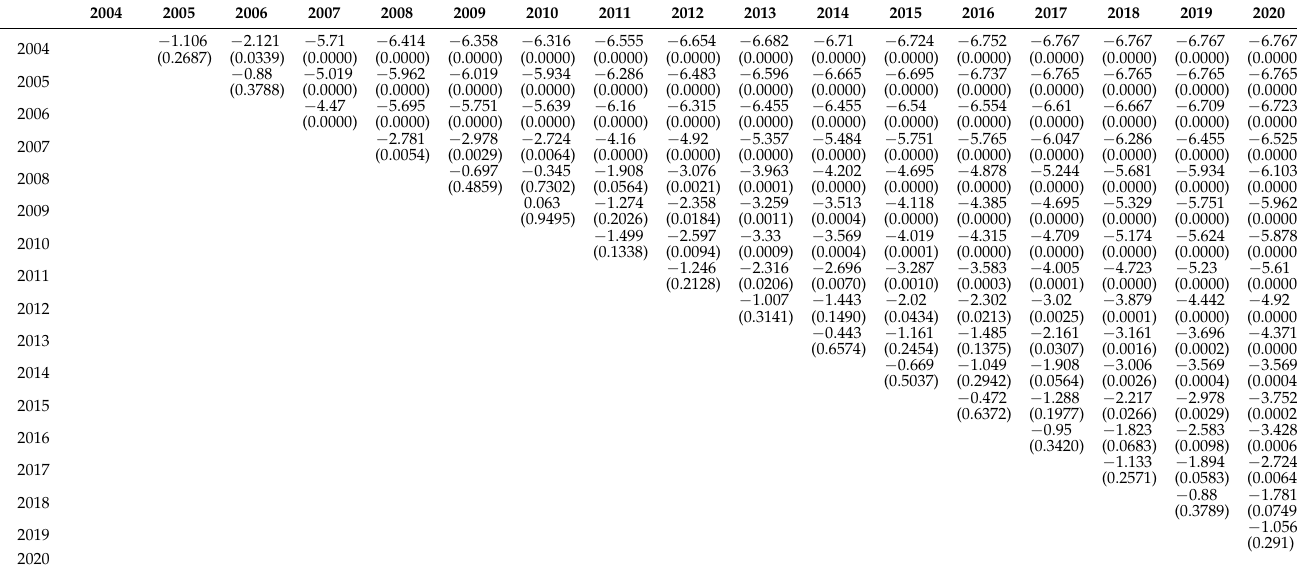
Table A1. The Increasing Rent Pattern: Mann–Whitney Test Basing on Premium